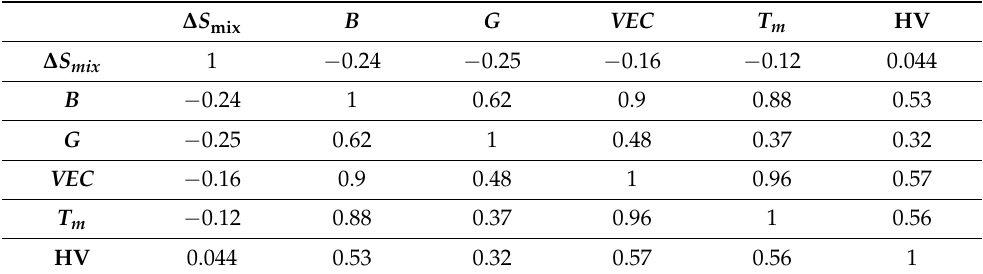
Table 1. The calculated Pearson’s correlation coefficients which are related to different features of high entropy alloys (HEAs) in 128 data